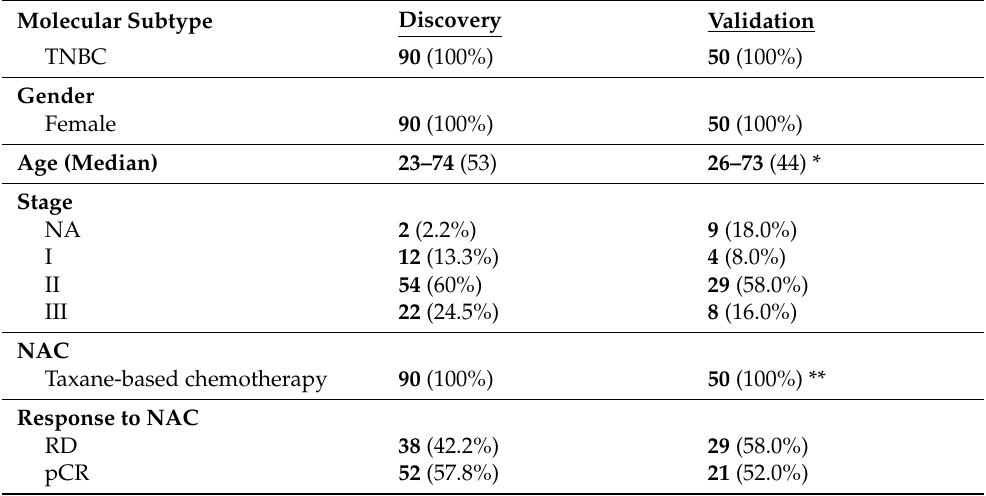
Table 1. Characteristic features of study population in the discovery and validation